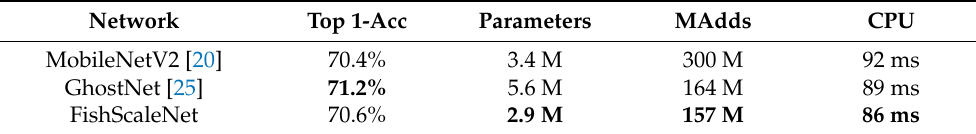
Table 4. Performance on ImageNet of different lightweight